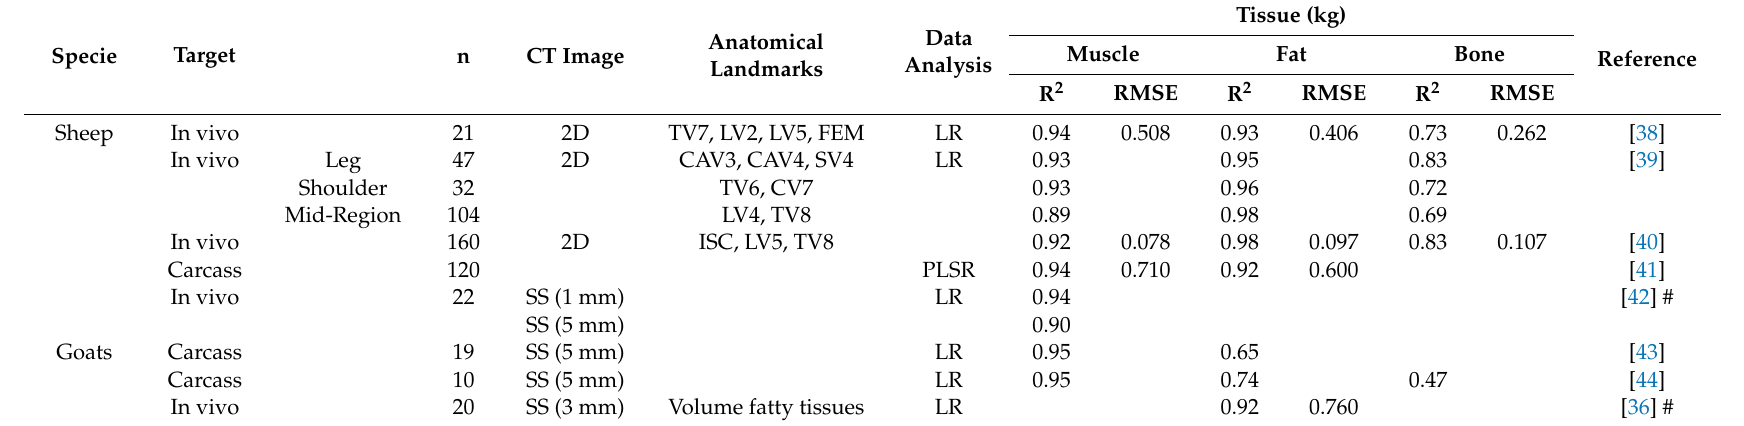
Table 2. Summary of applications of computed tomography imaging for prediction of carcass composition of sheep and